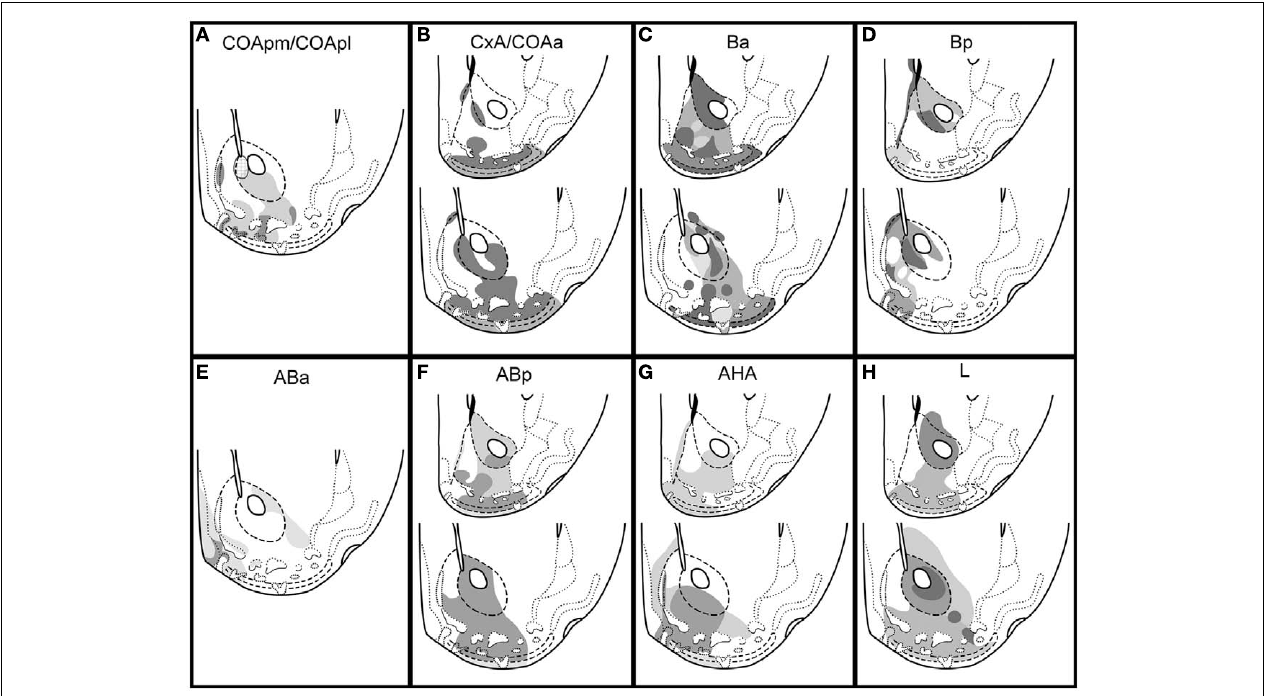
of the terminal fields, as inferred from our injections, is represented as different gray levels (the darker the denser).The patterned area in the medial AcbC in (A) indicates a terminal field that is labeled after the injection in the COApm but not in the injection centered in the COApl. For abbreviations, see